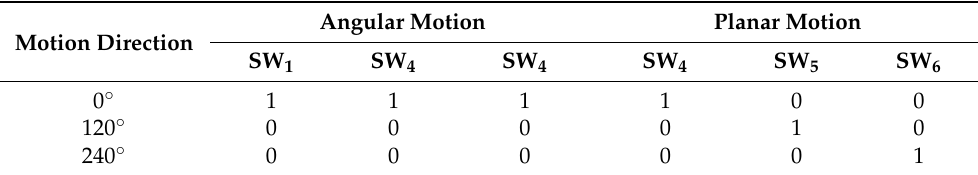
Table 1. Switching between electrodes used to control motion